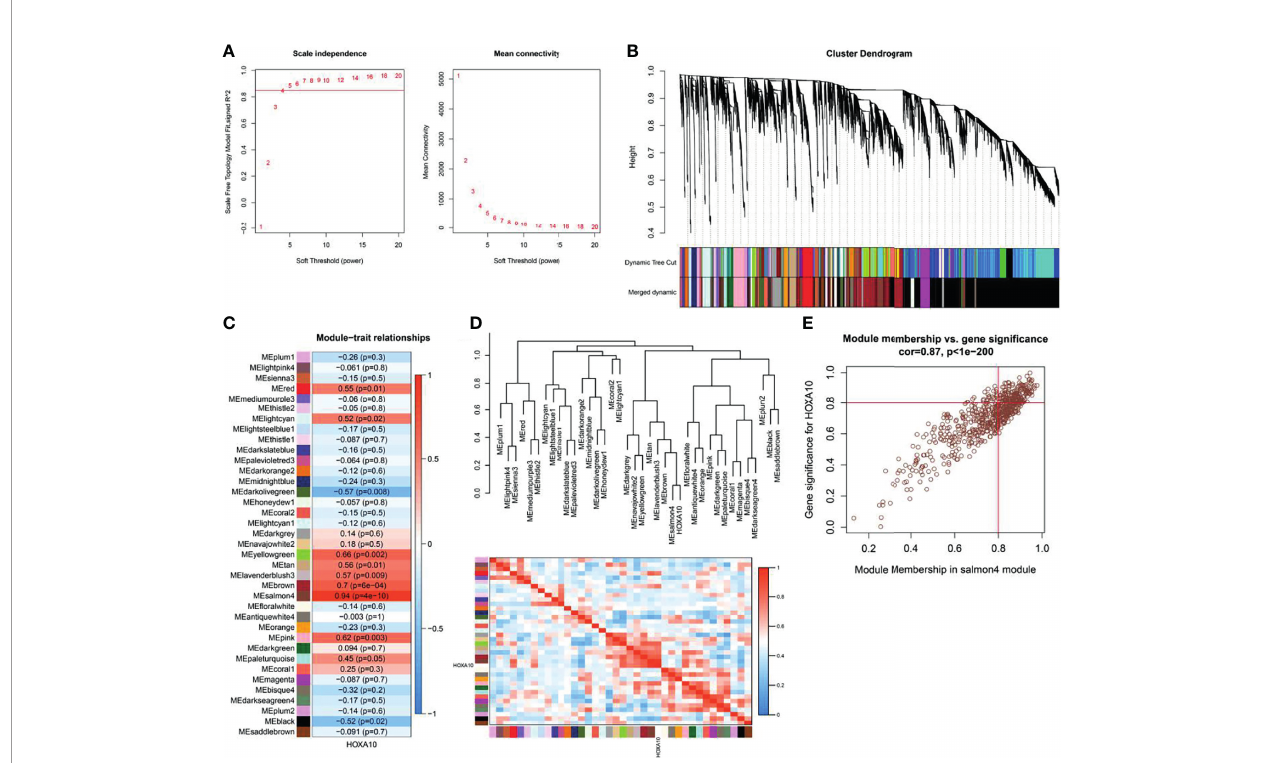
FIGURE 3 | Weighted gene co-expression network analysis. (A) Selection of the optimal soft-thresholding power for the scale-free network. (B) Module clustering dendrograms. (C) Correlation analysis of the module most associated with HOXA10 (Pearson ’ s correlation coef fi cient and the corresponding p-value are shown in the horizonal bars). (D) Cluster plot of the relationship between HOXA10 and the 37 modules. (E) Scatter plot of the genes in salmon4 module showing the relationship between GS and MM (GS, gene signi fi cance; MM, module